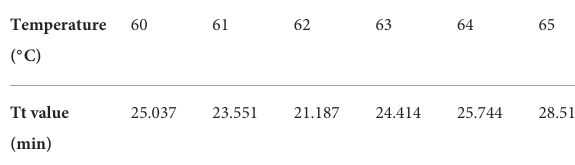
TABLE 3 Threshold times ( Tt ) of LAMP at different